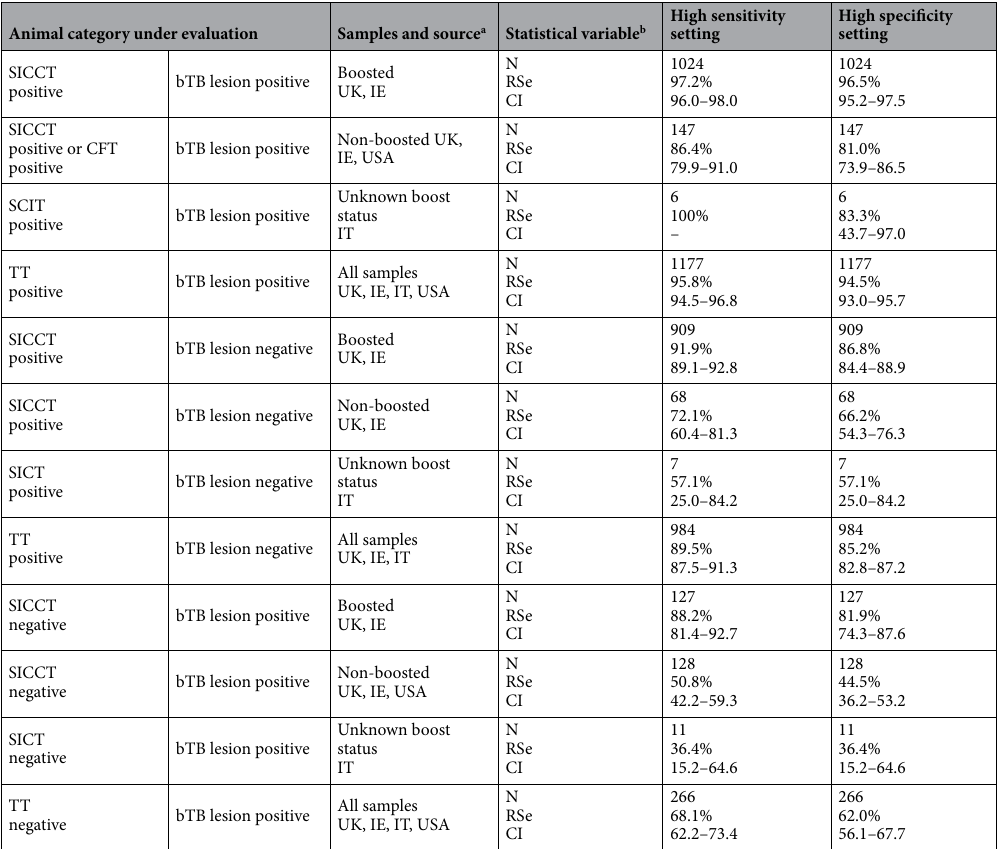
Table 5. Relative sensitivity of the Enferplex Bovine TB antibody test in TT positive animals with and without lesions. Diagnostic sensitivity was estimated at the high sensitivity and high specificity settings using reference sera from SICCT positive animals showing bTB lesions at post-mortem. a Boosted- samples taken within anamnestic window (5–30 days post tuberculin injection); non-boosted—samples taken outwith the anamnestic window; United Kingdom (UK), Ireland (IE), Italy (IT); United States of America (USA). b N = number; RSe—relative sensitivity; CI—95% Confidence